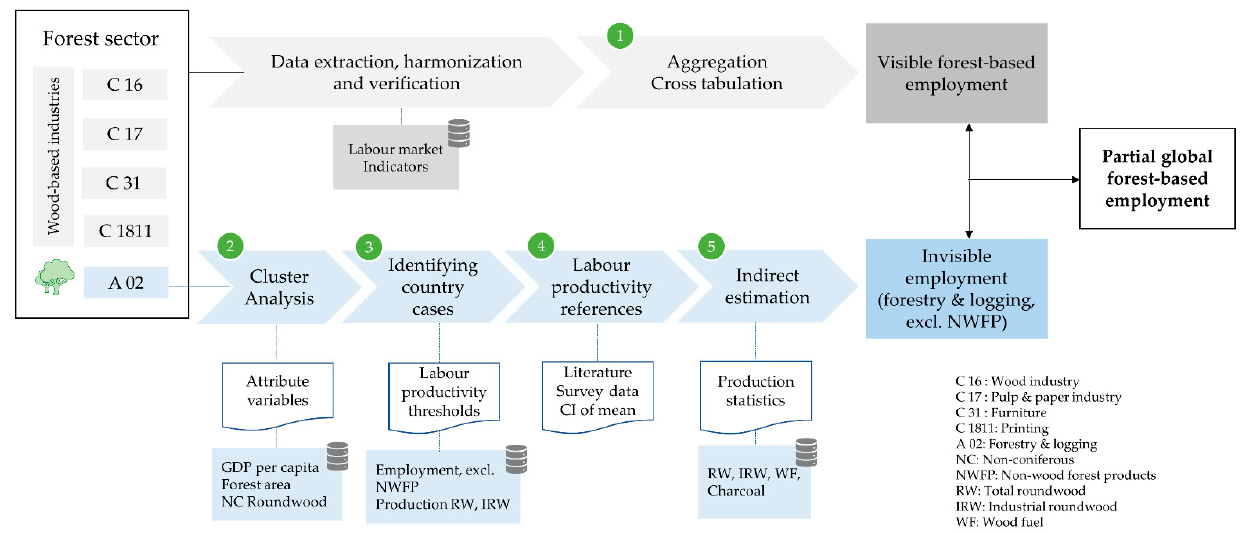
Figure 1. Analytical framework.